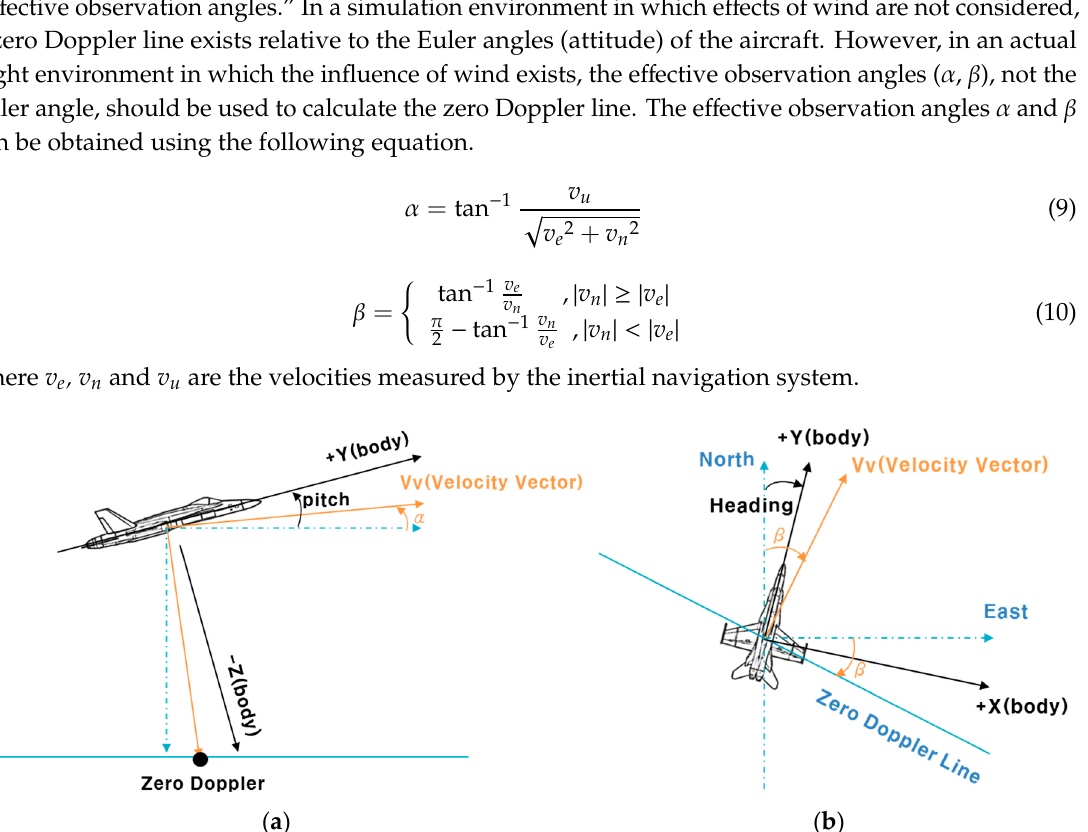
Figure 9. Comparison between aircraft’s attitude and velocity vectors in actual flight environment: ( a ) side view; ( b ) top view [12].